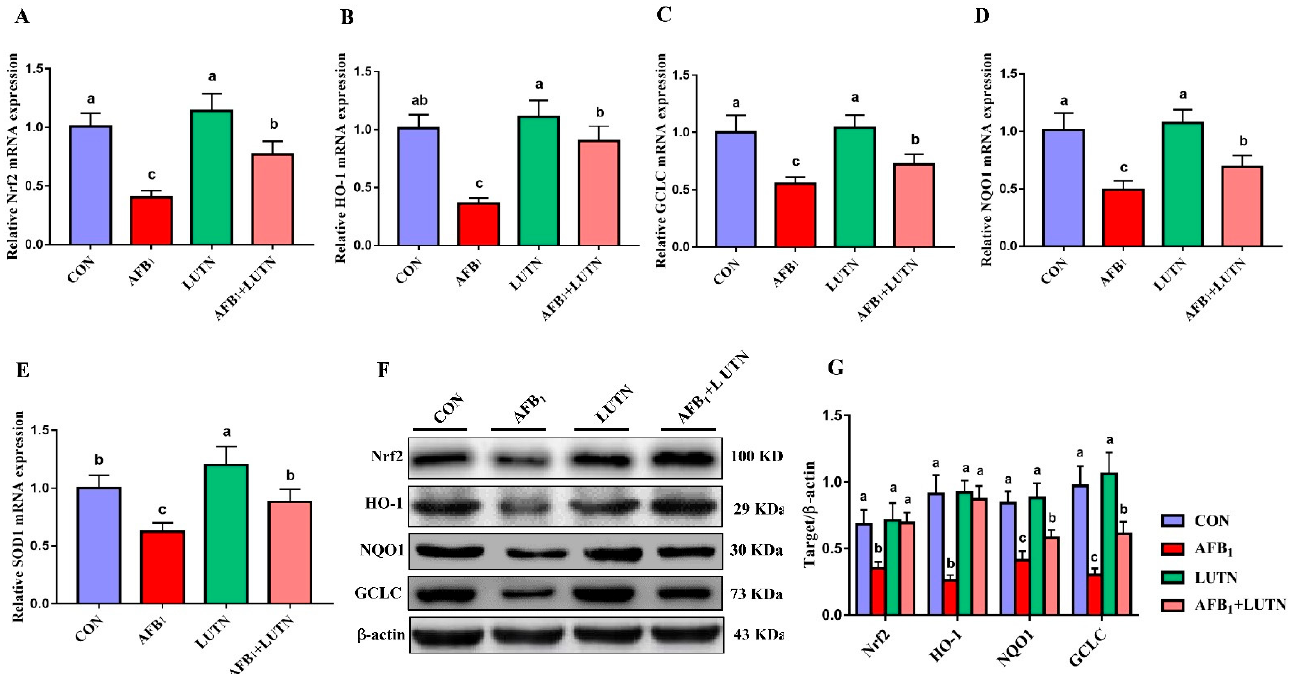
Figure 7. Luteolin treatment activates the Nrf2 signaling pathway in the liver of AFB 1 exposed mice. The relative expression of Nrf2-mediated antioxidant signaling transcripts was analyzed by qRT-PCR. ( A – E ) The relative gene expression of Nrf2 and its downstream molecules, HO-1, GCLC, NQO1 and SOD1. The results are presented as mean ± SD ( n = 6). The expression of Nrf2 and its associated proteins was detected by western blotting. ( F ) Western blots for Nrf2, HO-1, GCLC, and NQO1. ( G ) Quantification of western blots for Nrf2, HO-1, GCLC, and NQO1. The results are presented as mean ± SD ( n = 3). a–c Columns with different lowercase letters indicated significant differences between the compared groups ( p < 0.05). Nuclear erythroid-2-related factor (Nrf2); glutamate-cysteine ligase catalytic subunit (GCLC), heme oxygenase-1 (HO-1); superoxide dismutase 1 (SOD1); quinone oxidoreductase 1 (NQO1).